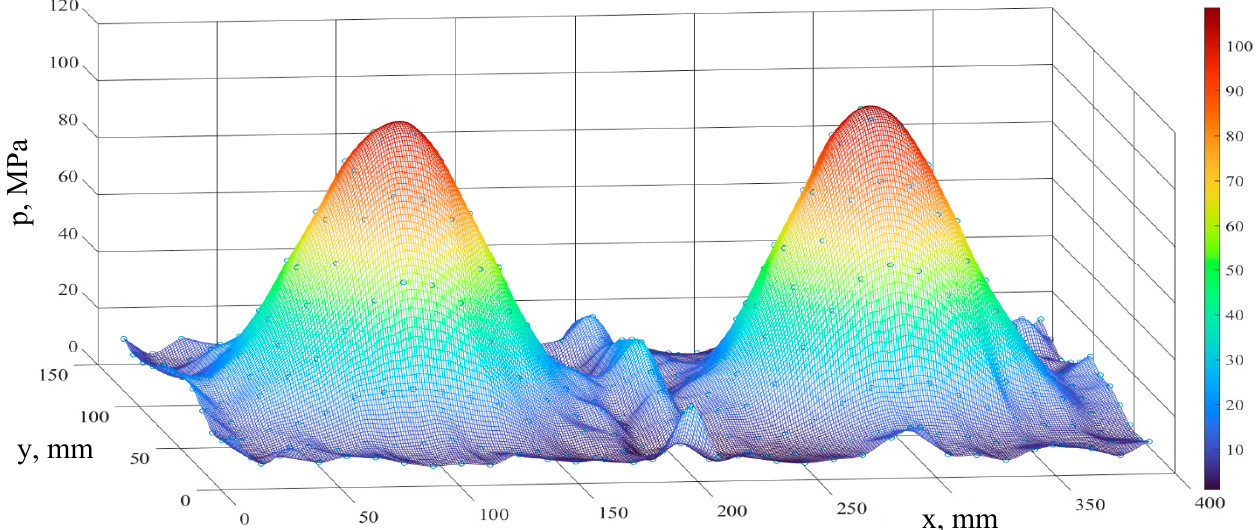
Figure 5. Three-dimensional representation of the pressure field generated by the simultaneous explosion of the two wires plotted from the mean test values.